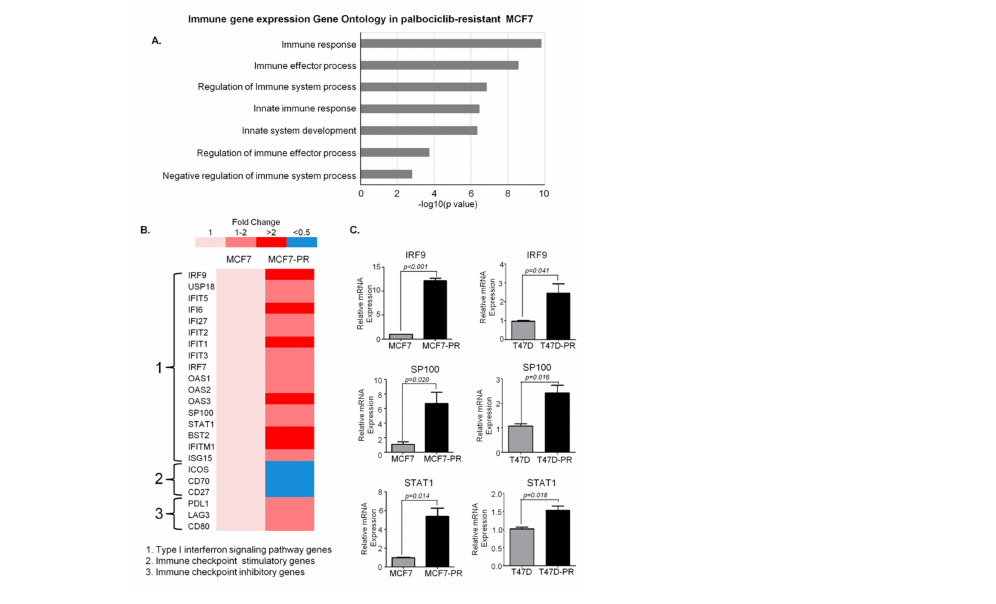
Figure 2. DEG analysis in the MCF7 cells revealing immune pathway deregulation in palbociclib- resistant cells. ( A ) To identify DEGs, the fold change in mRNA expression of the palbociclib-resistant cells was divided by that of the sensitive cells (e.g., MCF7-PR/MCF7 or T47D-PR/T47D). GO Biology Process terms were used for pathway analysis. The gProfileR R package (0.7.0) was used to identify statistically enriched GO Biology Process terms in our DEGs. The bar graph shows that GO biological process terms related to immune response were enriched in DEGs. The X axis indicates p values in the specified formula − log 10 ( p value). The bar represents the statistical significance of each GO term. All GO terms in Figure 2 were statically significant (adjusted p value < 0.05). The gene list of each GO term overlapping with DEGs is provided in Table 1. ( B ) Panels of specific immune pathway genes are demonstrated. Type I IFN genes and immune checkpoint inhibitory/stimulatory genes were detailed in these panels to compare their expression levels between palbociclib-sensitive and resistant MCF7 cells. ( C ) Quantitative real-time PCR data demonstrate increased type I IFN signals. P values were calculated by Student’s t -test. Data are presented as means ± standard deviation of triplicate experiments. Table 1. GO Biological Process terms related to immune responses were enriched in DEGs between MCF7-PR and MCF7